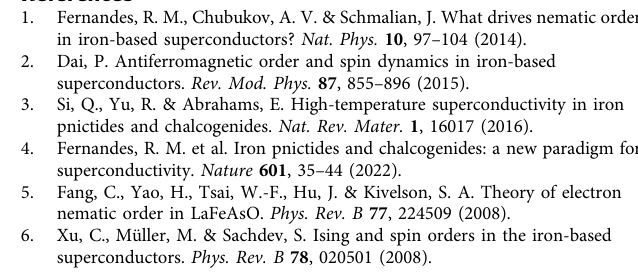
2 g nematic susceptibility and its inverse are plotted in Fig. 5a, b. The excellent agreement with the experimentally measured 2 m 66 (cid:2) 2 m 0 j (cid:2) 1 (Fig. 5c, d) con fi rms the orbitally selective and j 2 m 66 66 nature of the nematic susceptibility.